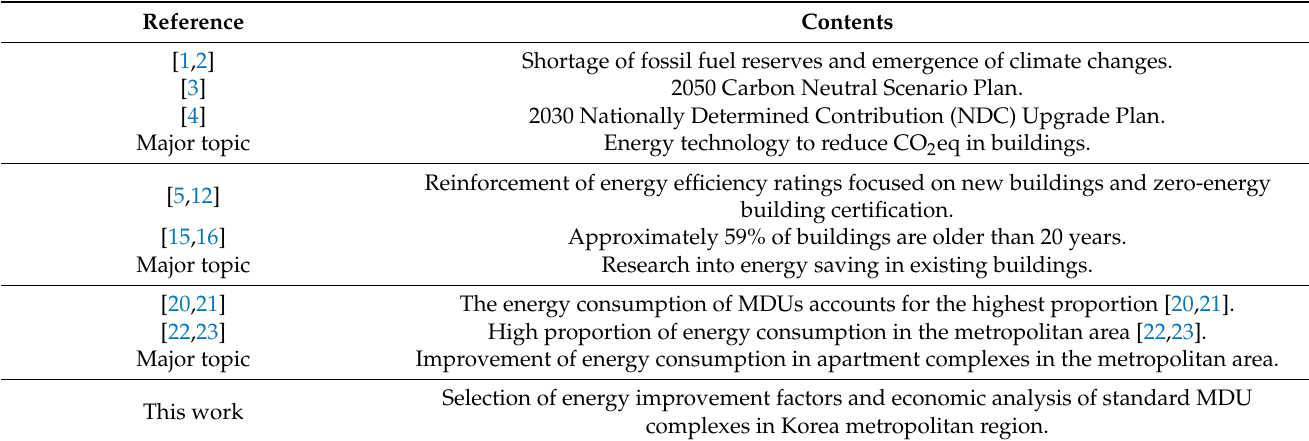
Figure 2. ( a ) Age status of domestic buildings as of March 2021 [15,16]; ( b ) Comparison of energy consumption by region for MDUs and other uses [22]. Table 1. Comparison of literature